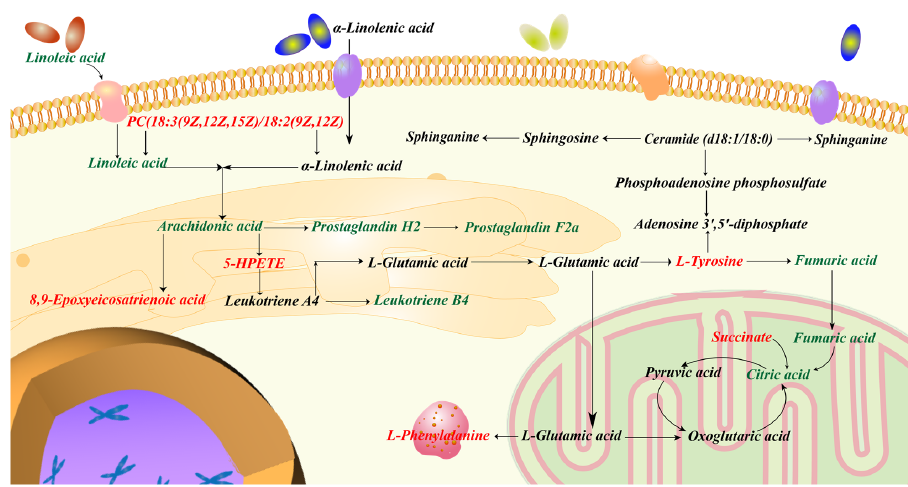
Figure 11. The network of “biomarkers-targets-pathways.